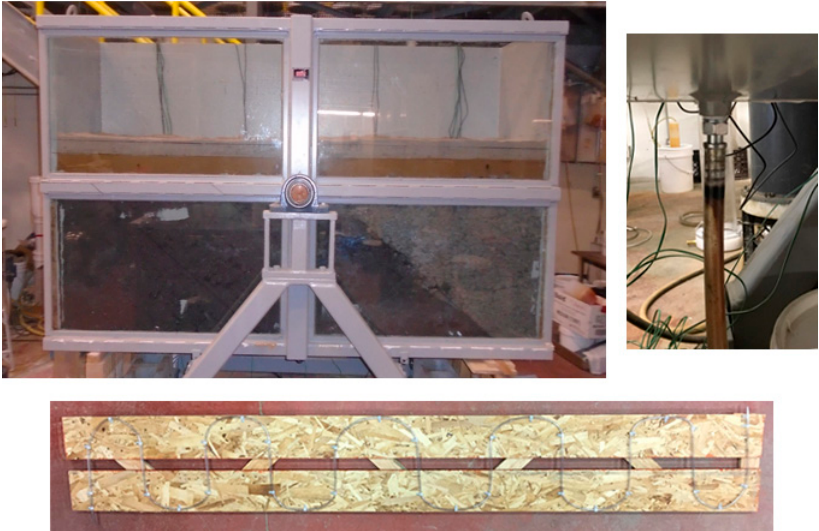
Figure A1. Photos of the laboratory experimental set-up. Top left : Front view of the laboratory scale model. HI rock is the dark grey material on the left which was deposited in three segregated zones; anorthosite is the light grey material (to the right of the HI); sand is orange-brown in colour along the top with crushed anorthosite (light grey) above to form the FCL. The tank was pivoted at an angle of 5° for the duration of the experiments with steady-state flow rates. Top right : Drainage tubes 1 cm in diameter that allow effluent to freely drain into the collection buckets below. Bottom : Set up of tubing with drainage holes installed along the top of the lab model to distribute the water applied at 180 L day − 1 .